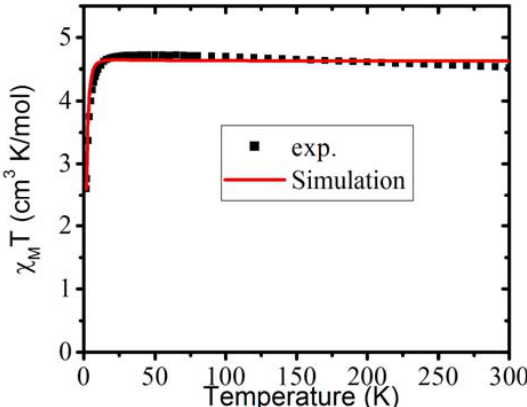
Figure 8. The magnetic χ M T vs. T plot of compound 1 , where the black squares are the experimental data, and the simulation based on Equation (1) is the red solid line.